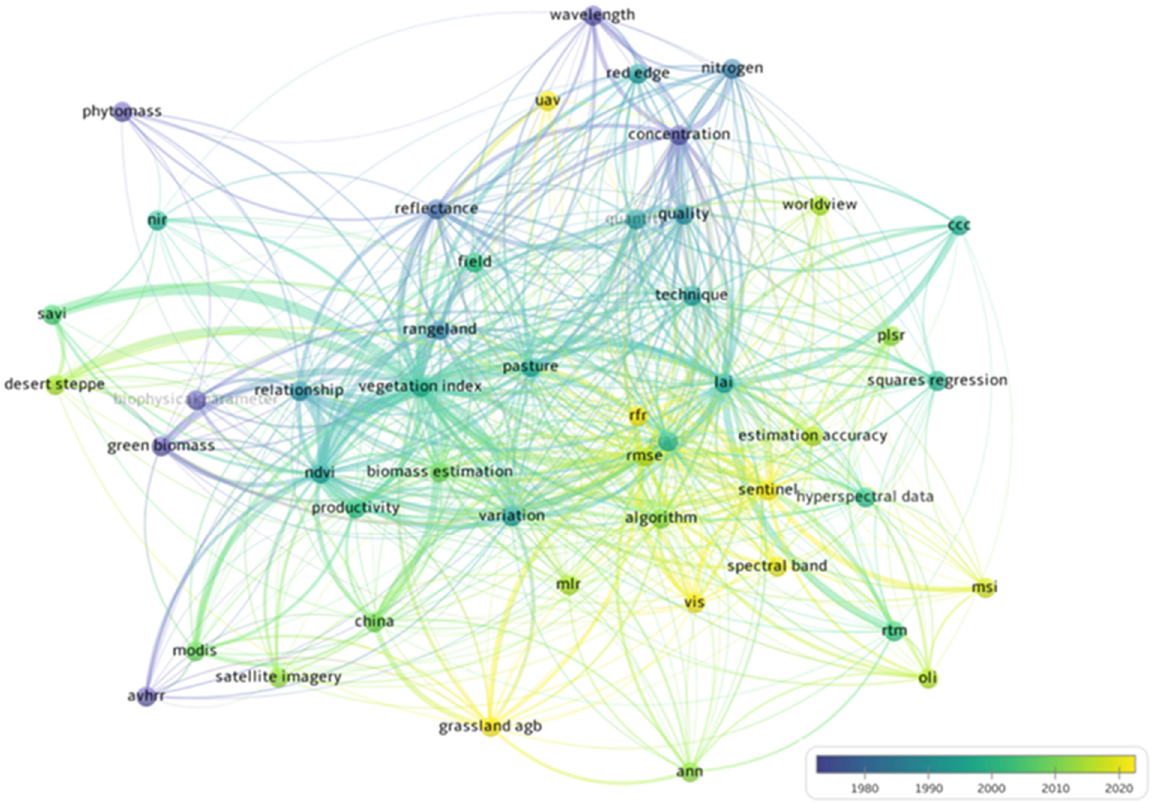
Figure 3. Evolution of key terms in estimating grassland productivity using remote sensing, based on the data derived from the abstracts and titles of the selected literature.